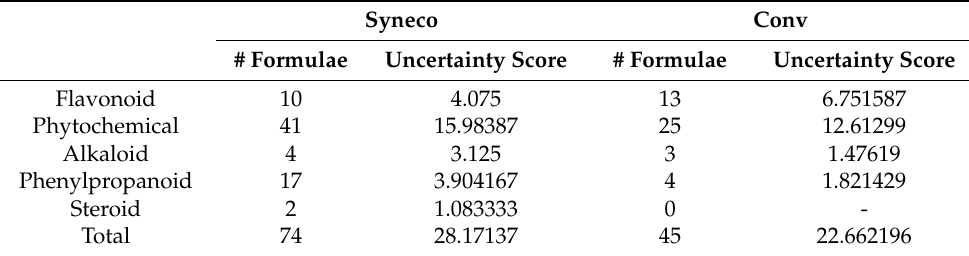
Table 2. KEGG BRITE compound classification. The numbers of di ff erent chemical formulae (# Formulae) associated with the Syneco- and Conv-distinctive loadings for each category of chemical ontology in KEGG BRITE were shown. Uncertainty Score is the sum of inverse numbers of structural isomers for each chemical formula. The smaller the number, the greater the number of structural isomers, indicating the higher uncertainty of compound identification. See the Supplementary Materials Files S6–S8 for more